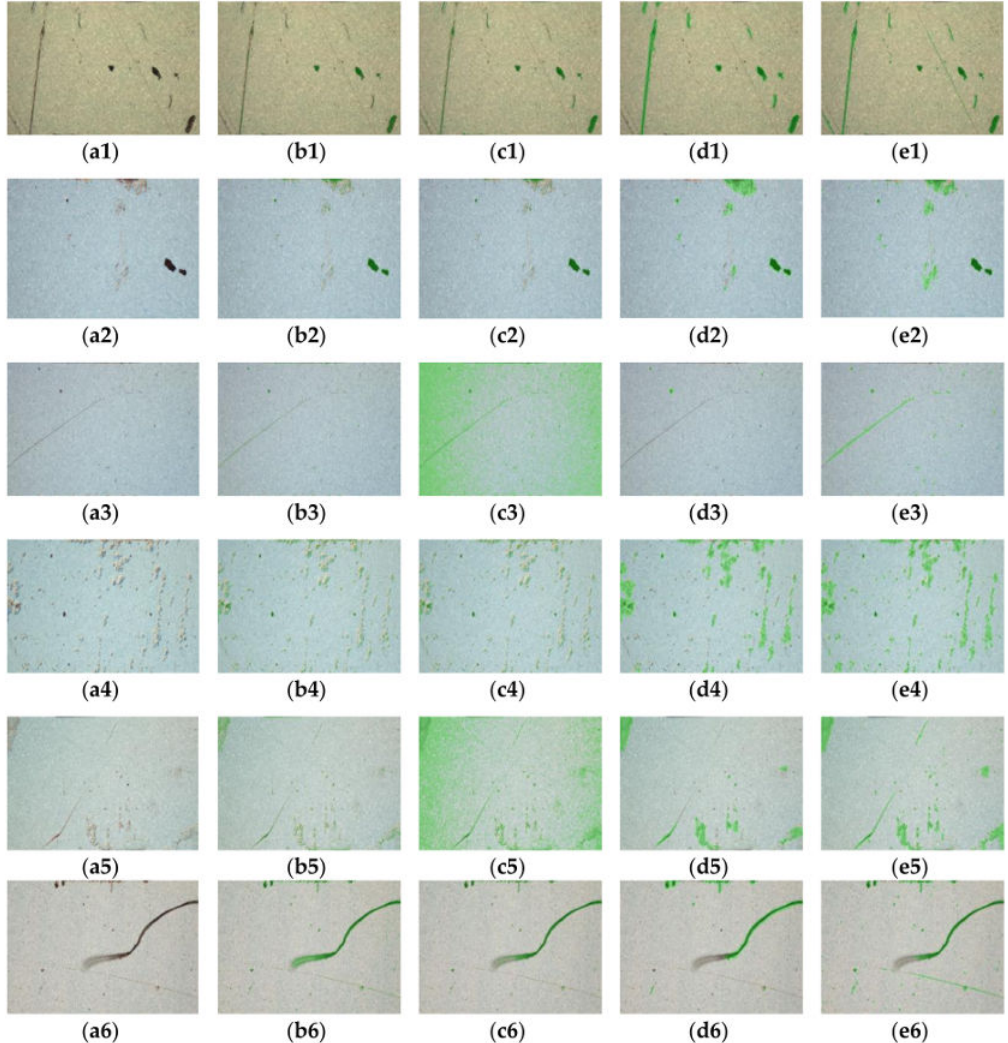
Figure 6. Segmentation results. The six rows are examples of defective images. ( a1 – a6 ) raw images, ( b1 – b6 ) results of Kittler [19], ( c1 – c6 ) results of Otsu [17], ( d1 – d6 ) results of a fully